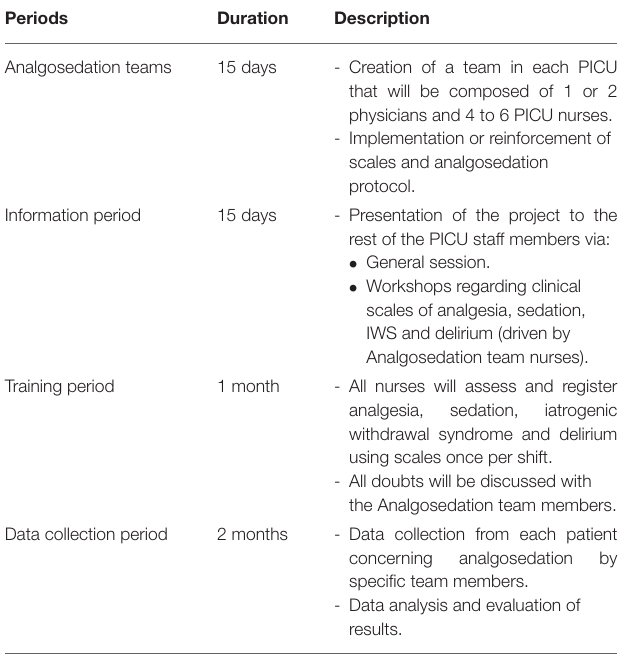
TABLE 1 | Phases of the MONISEDA project training in each